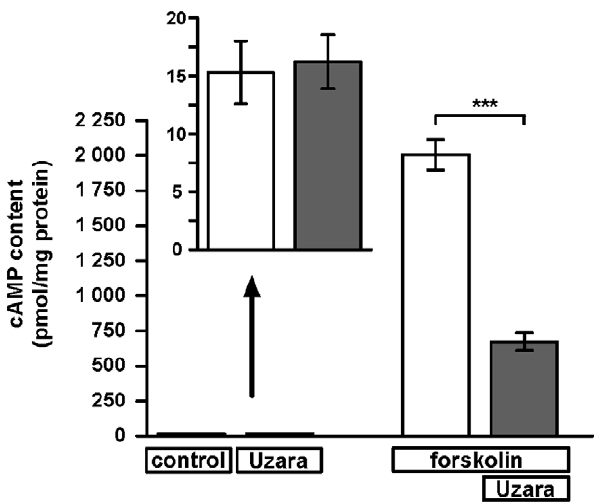
Figure 2. Inhibitory effect of Uzara on the forskolin-induced accumulation of intracellular cAMP in HT-29/B6 cells. HT-29/B6 monolayers were incubated basolaterally with 50 m g/ml Uzara 30 min prior to basolateral forskolin (10 m M) addition. After an incubation time of 1 h, cell lysates were prepared and the content of cAMP was assayed with EIA. The data shows that forskolin increased the intracellular cAMP level, whereas Uzara partly blocked this rise in cAMP. Values are expressed as mean 6 s.e.m. (n=5-6). Asterisks indicate difference